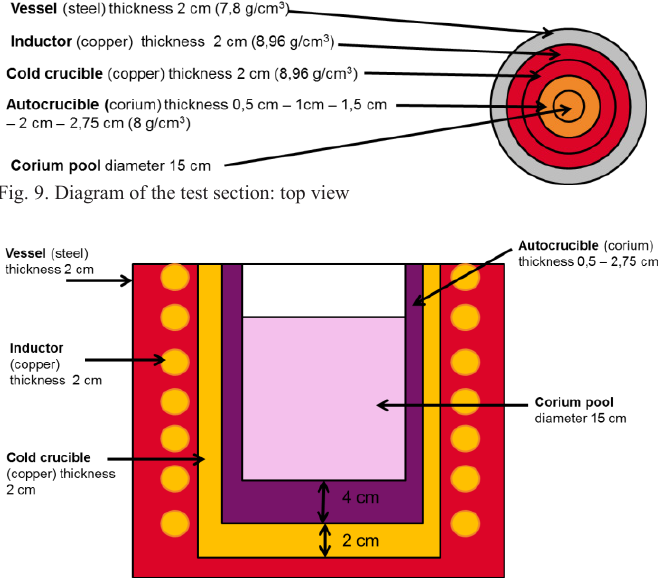
Fig. 9. Diagram of the test section: top view